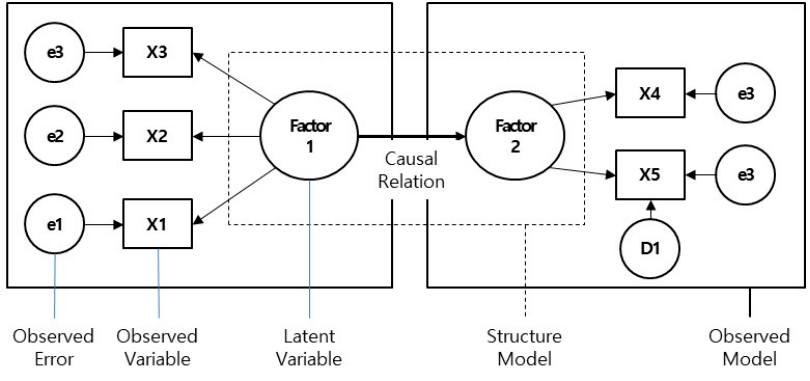
Figure 2. Basic concept of structural equation model.